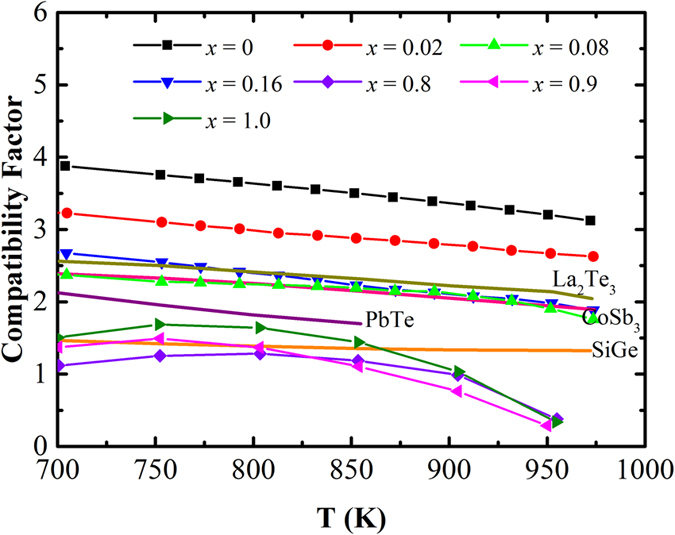
Temperature dependence of the thermoelectric compatibility factor for the Cu1.98SxSe1−x (x = 0, 0.02, 0.08, 0.16, 0.8, 0.9, 1.0) samples.